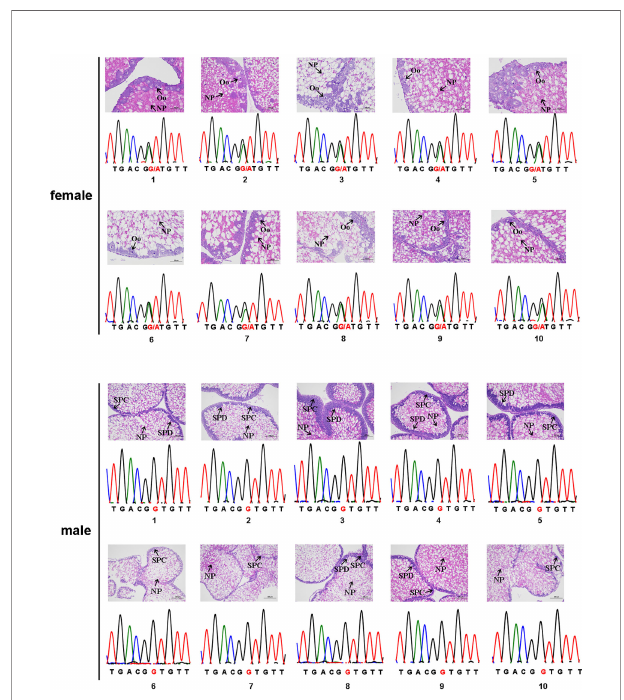
FIGURE 1 | The sex-associated SNP of the Strongylocentrotus intermedius . The female genotype is G/A heterozygous and the male genotype is G/G homozygous. NP, nutritive phagocytes; SPC, spermatocyte; Oo, oocyte; SPD,